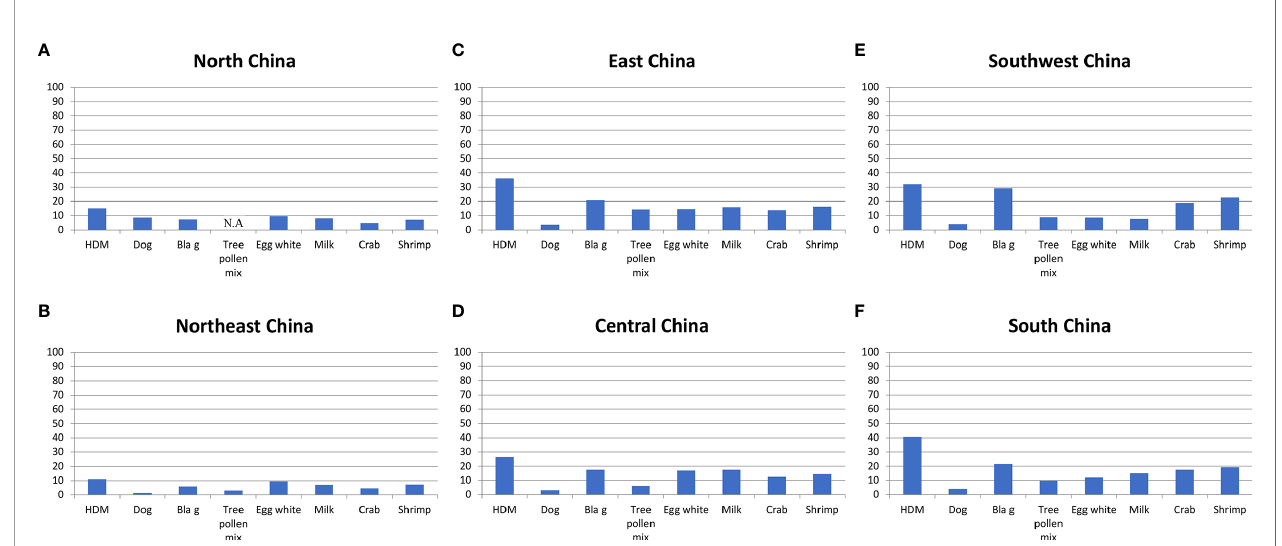
FIGURE 4 | Frequencies (y-axes: percentages of positive subjects) of IgE sensitizations to different allergen extracts according to (35) (x-axes: HDM; dog; Bla g; tree pollen mix; egg white; milk; crab; shrimp) as determined by IgE serology in different areas of China ( (A) : North China; (B) : Northeast China; (C) : East China; (D) : Central China; (E) : Southwest China; (F) : South China). Depending on the tested region, frequencies of IgE recognition varied approximately as follows: HDM: 11- 40%; dog: 1-9%; Bla g: 7-30%; tree pollen mix: 3-14%; egg white: 8-17%; milk: 7-18%; crab: 4-19%; shrimp: